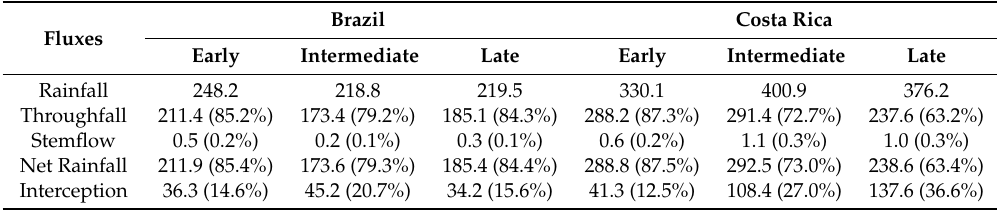
Table 2. Gross rainfall (mm) and fluxes (% and mm) recorded among successional stages of tropical dry forest in Brazil and Costa